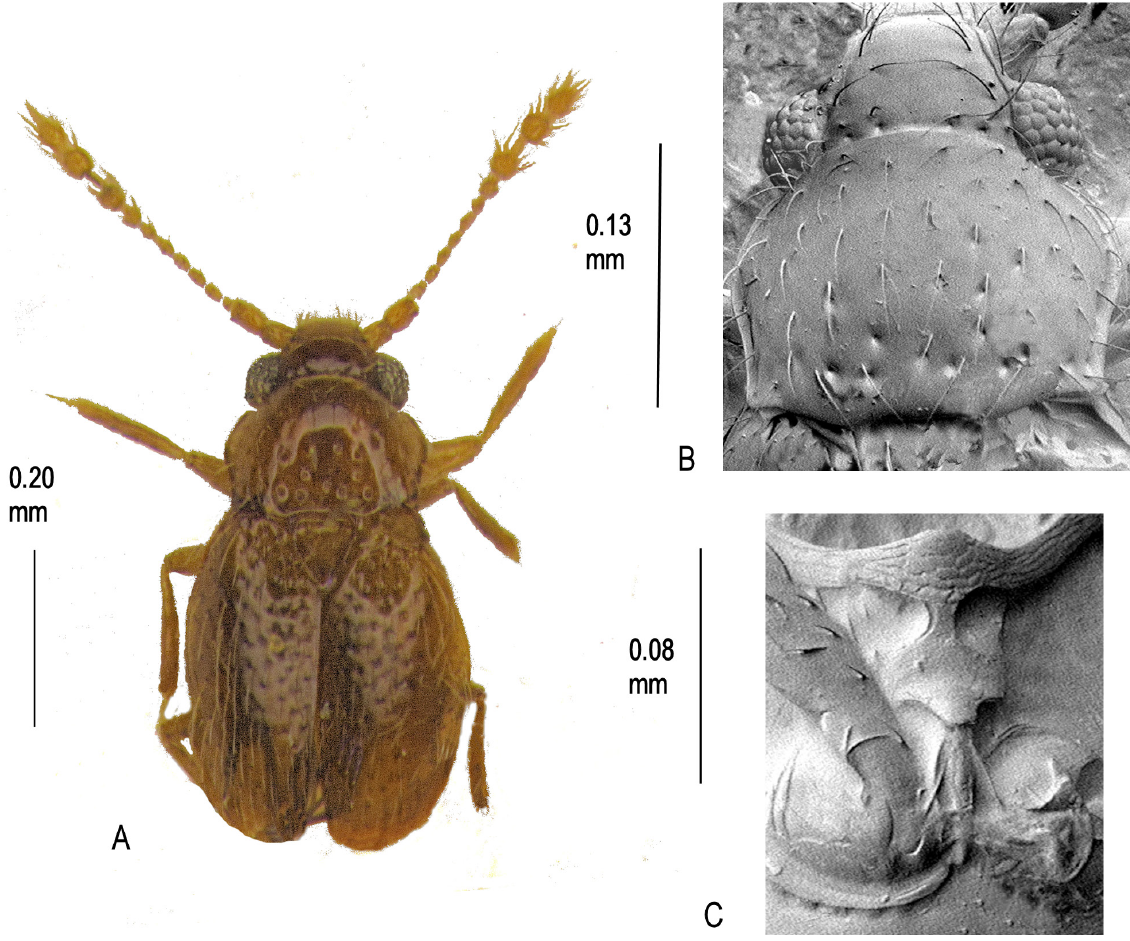
Fig. 113. Cissidium upiense sp. nov. A . Habitus. B . Pronotum, × 565. C . Mesoventrite showing median process of collar, mid-keel and keel,